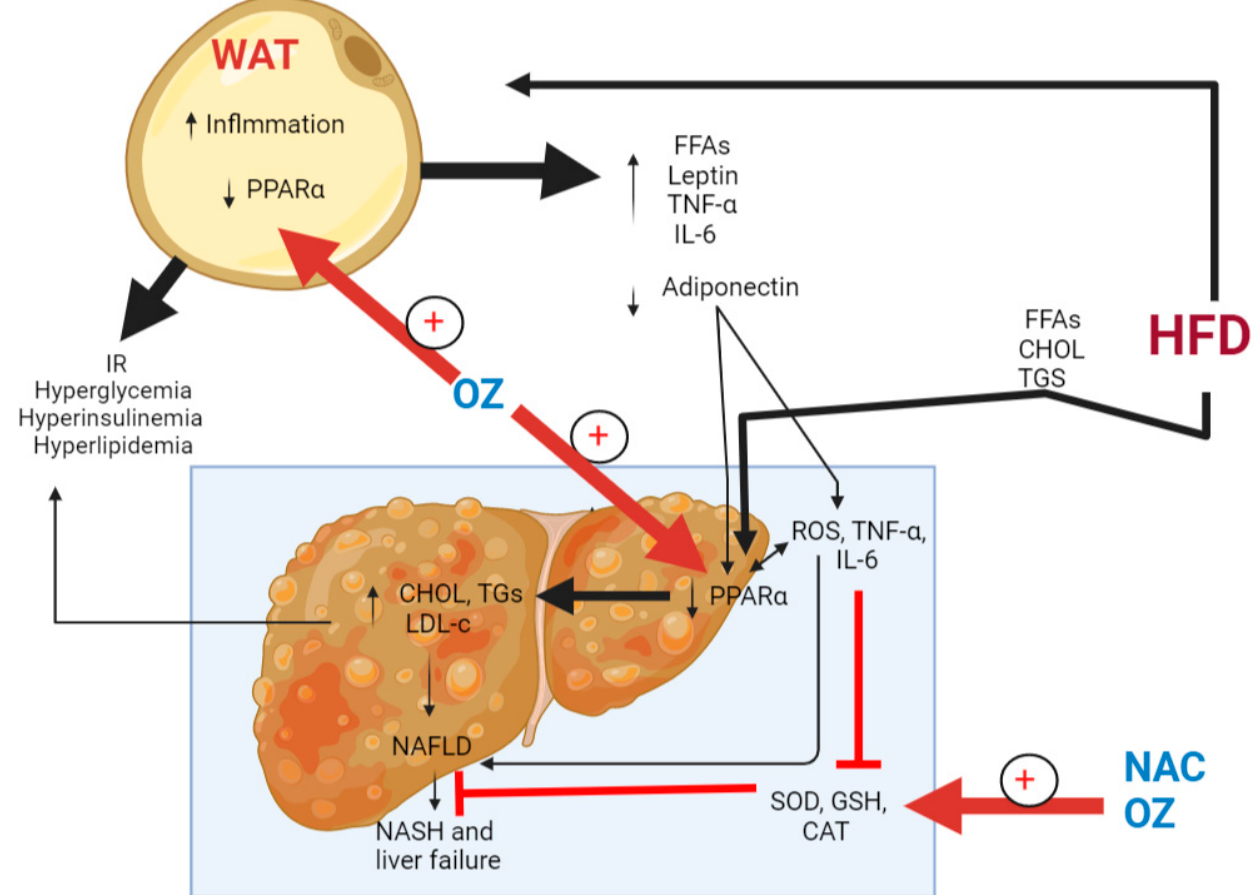
Figure 7. A graphical abstract showing the synergistic mechanistic effect of γ -oryzanol and N-acetylcysteine (NAC) against high-fat diet (HFD) induced non-fatty liver. In the figure, HFD promotes inflammation and insulin resistance (IR) and downregulates PPAR α in the white adipose tissue (WAT). This activates lipogenesis in WAT, which increases the influx of inflammatory cytokines and free fatty acids (FFAs) to the liver. It also increases the release of leptin and lowers those of adiponectin. Fruthermore, the influx of dietary FFAs increases in the liver of rats. As a result of all these factors, the generation of reactive oxygen species (ROS), tumor necrosis factor- α (TNF- α ), and interleukin-6 (IL-6) are stimulated in the livers of rats which scavenge major antioxidants such as glutathione (GSH), superoxide dismutase (SOD), and catalase (CAT). In addition, the levels PPAR α are decreased, which stimulates the hepatic de novo lipid synthesis and results in hepatic steatosis and non-alcoholic fatty liver disease (NAFLD). In the presence of low antioxidant power and high levels of ROS and inflammatory cytokines, the disease can progress to non-alcoholic steatohepatitis (NASH) and liver failure. NAC inhibits oxidative stress and inflammation by stimulating major antioxidant proteins, CAT, SOD, and GSH. On the other hand, γ -oryzanol stimulates GSH, SOD, and CAT and stimulates the levels of PPAR α and both the liver and WAT.